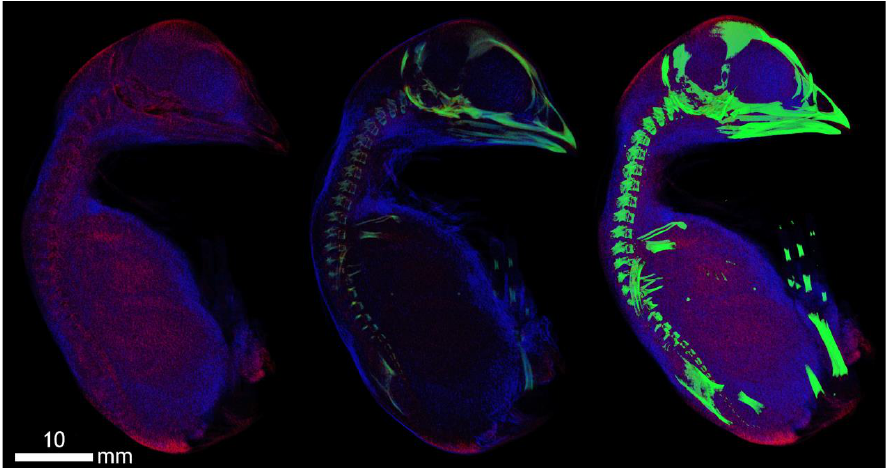
Figure A1. Dyed 19-day-old chicken (acquisition at anode voltage 100 kV, contrast agent ethanol). Ethanol fixed the surface structures of the soft tissues of the skin. The transition of the cartilaginous base of the skeleton (spine, skull, limbs) into bone forms is also shown.